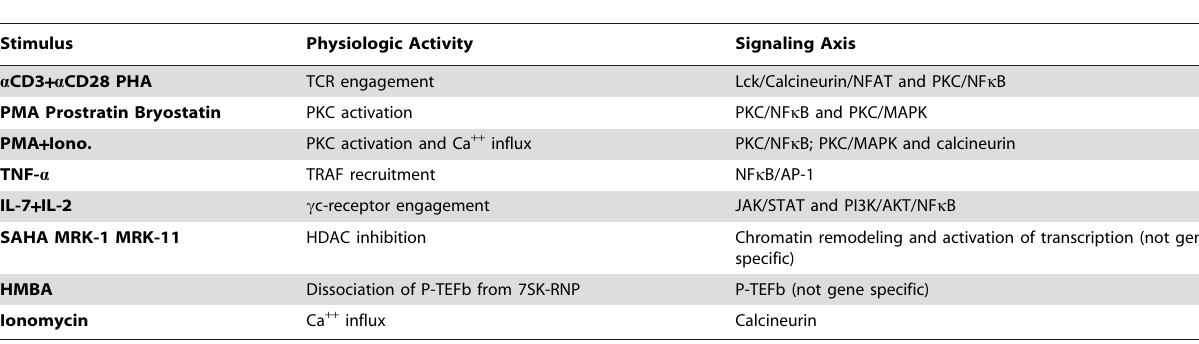
Table 2. List of stimuli used in this study and their corresponding signaling